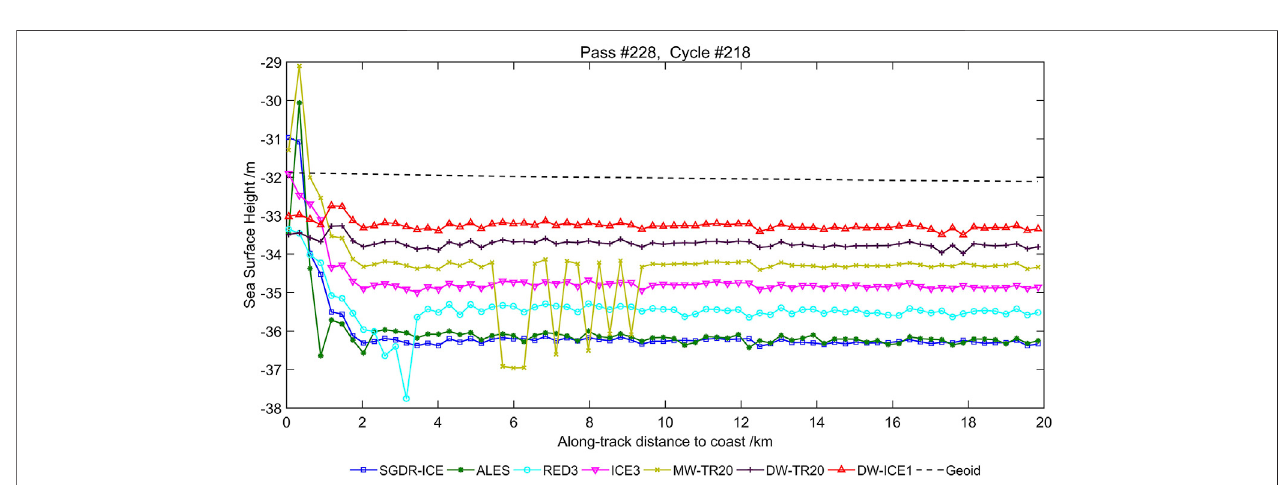
FIGURE 4 | Along-track sea surface heights retrieved by various retrackers. Arbitrary constants were added to the result of each retracker for visual clarity.